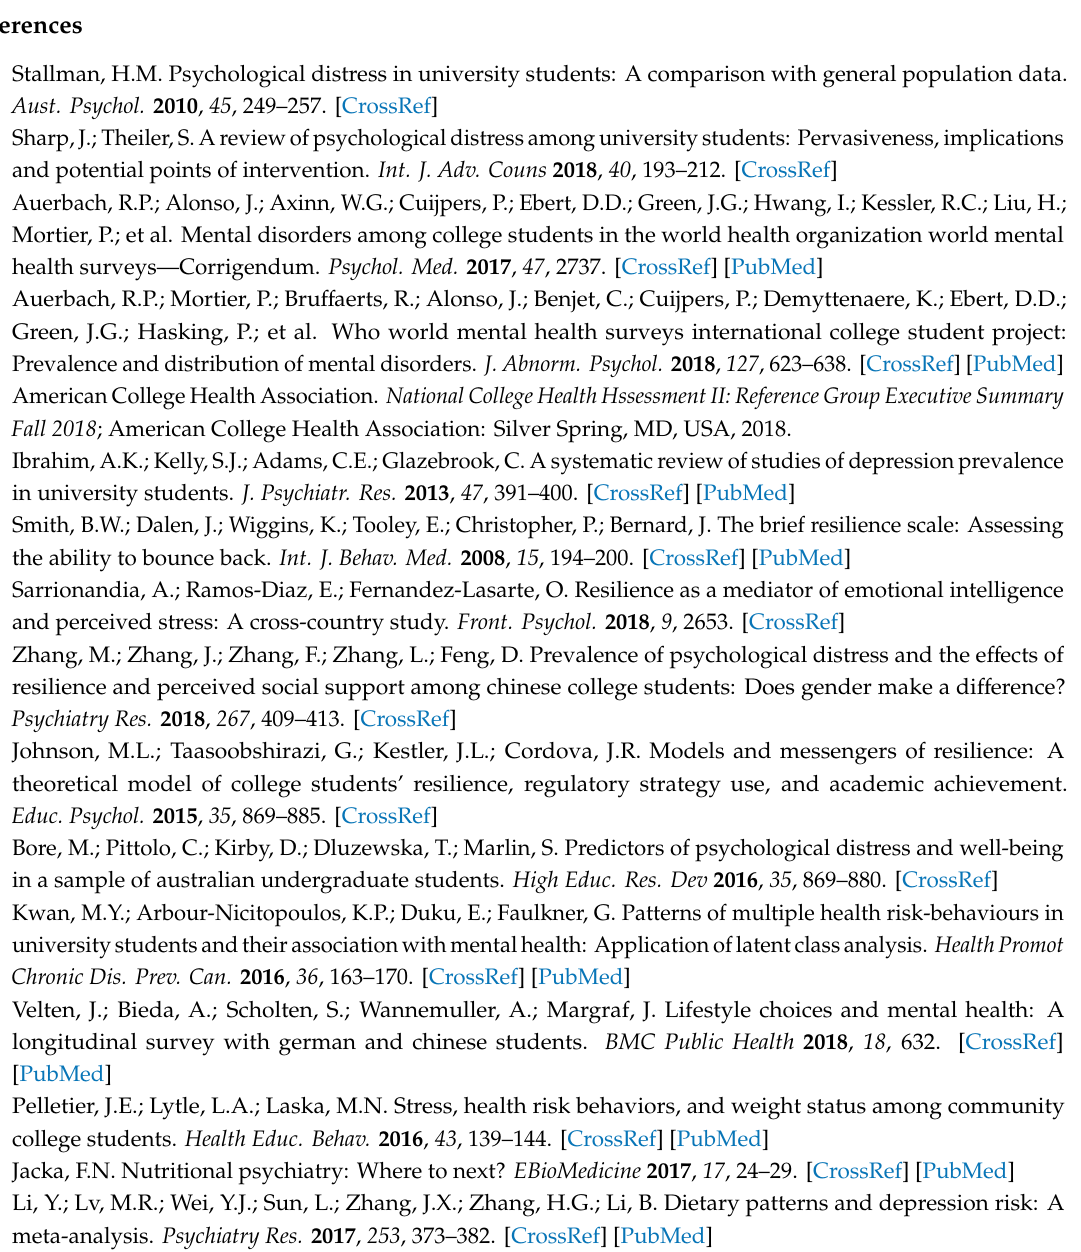
Table S1: Linear regression results of psychological distress and resilience scores with dietary intake in a sample of Australian university students ( n = 2710), including full results of confounder